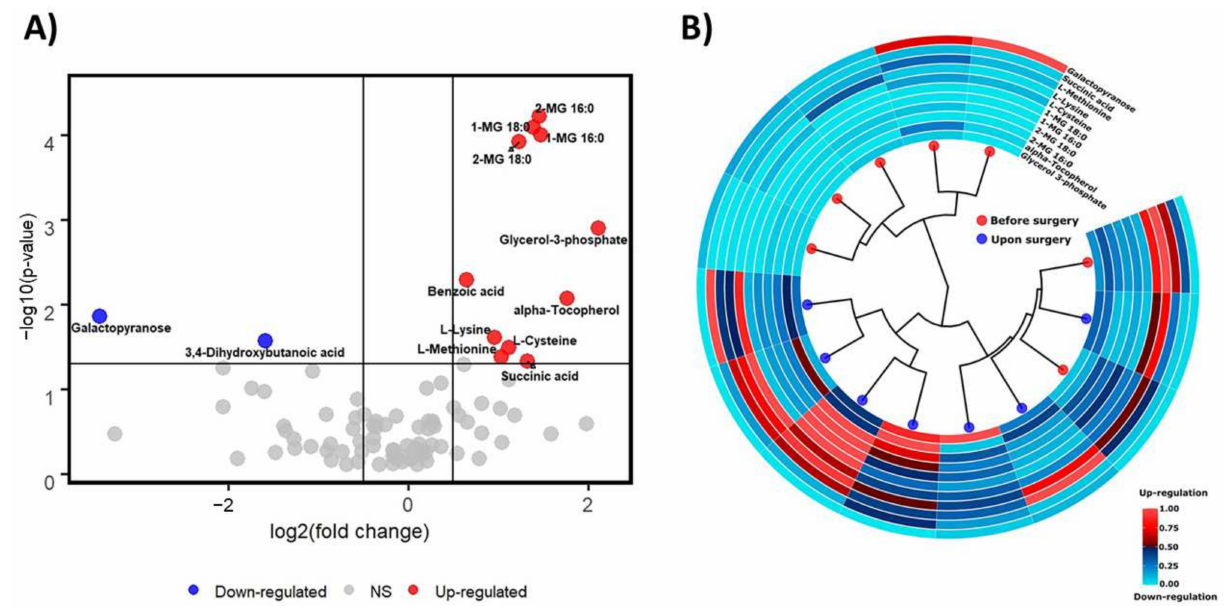
Figure 2. ( A ) Volcano plot shows metabolites with the raw p -value < 0.05 and simultaneously log2 (fold change) above 0.5; ( B ) Circular dendrogram and heatmap created using the set of biologically relevant metabolites. Further, 0–1 scaling was applied to normalize the abundance of individual metabolites in patients’ plasma prior- and post-surgery.